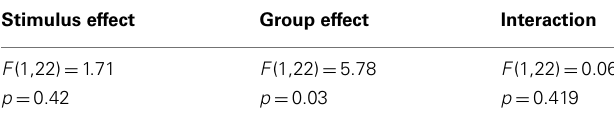
Table 1 | Results of the MANOVA on the PSE with the stimulus type (musical instruments/voices) as the repeated measure and the participants’ gender (male/female) as the independent measure.